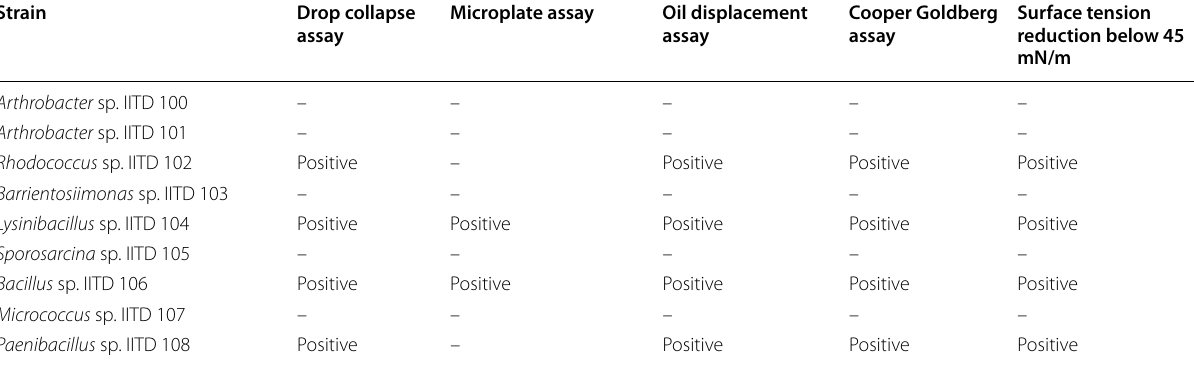
Table 4 Results of biosurfactant production assays with different members of the consortium Strain Drop collapse Microplate assay assay